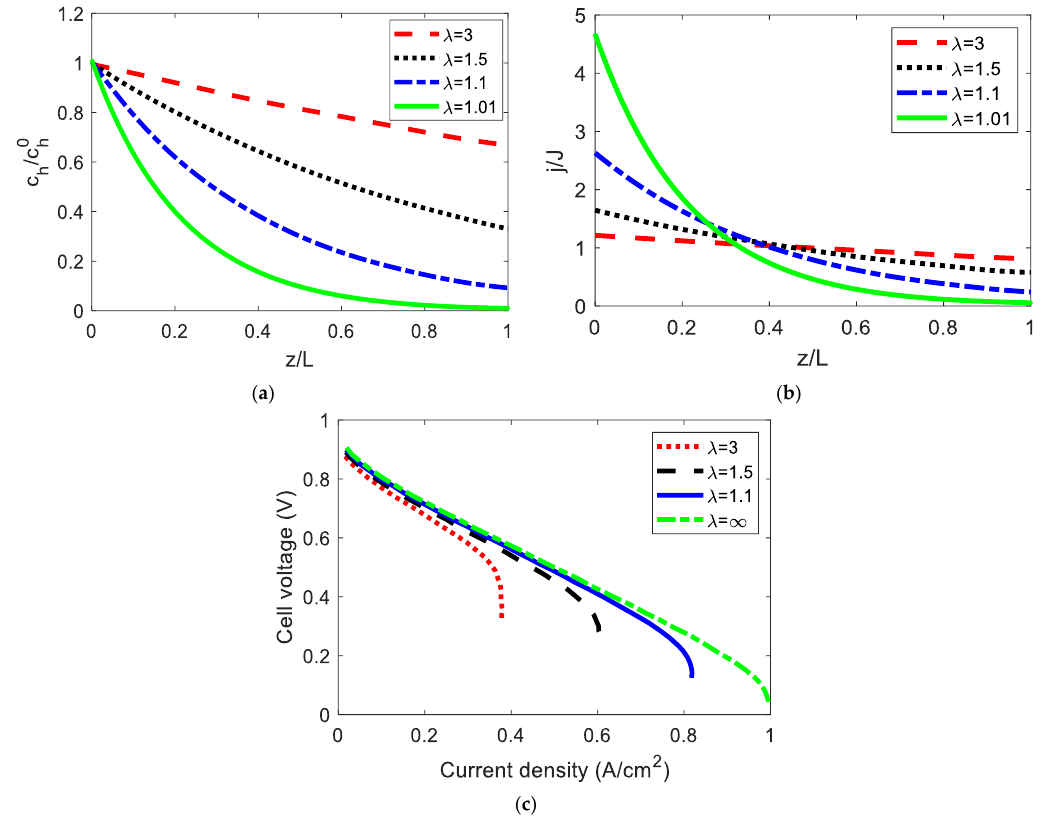
Figure 7. The changes in the ( a ) oxygen concentration, ( b ) local current density, and ( c ) cell voltage by the changes in the oxygen stoichiometry, λ , using Equations (33), (35), and (36).